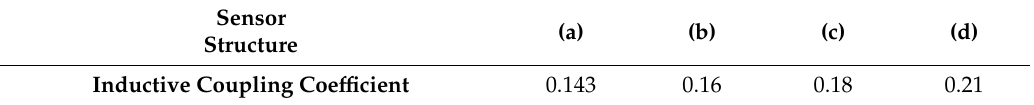
Figure 7. Magnetic-field flux density of ( a ) model-1; ( b ) model -2; ( c ) model-3 and ( d ) model-4 at 5-A conductor current. Table 2. Coil models with inductive coupling coefficient.